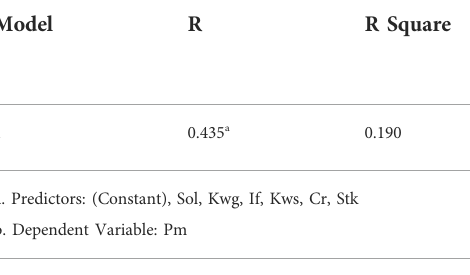
TABLE 8 Summary model corresponding to the dependent variable for Pm.